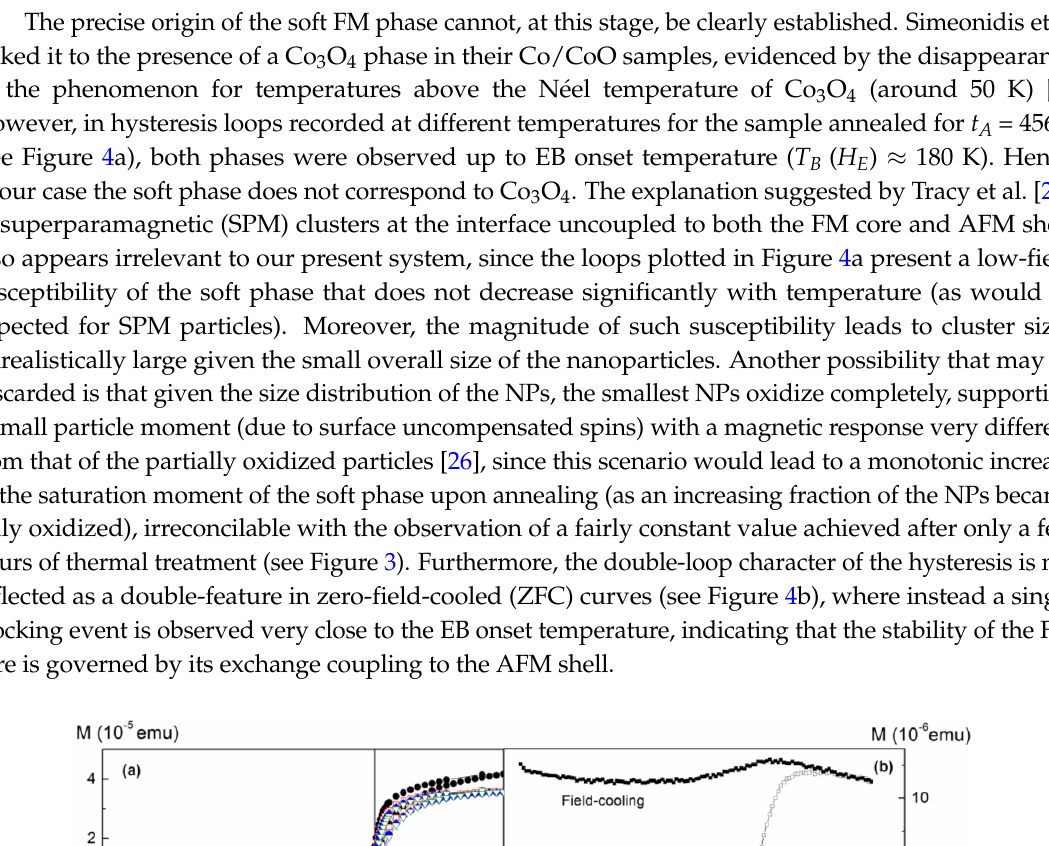
Figure 3. Annealing time dependence of the saturation moment of the hard and soft components of the hysteresis loop.